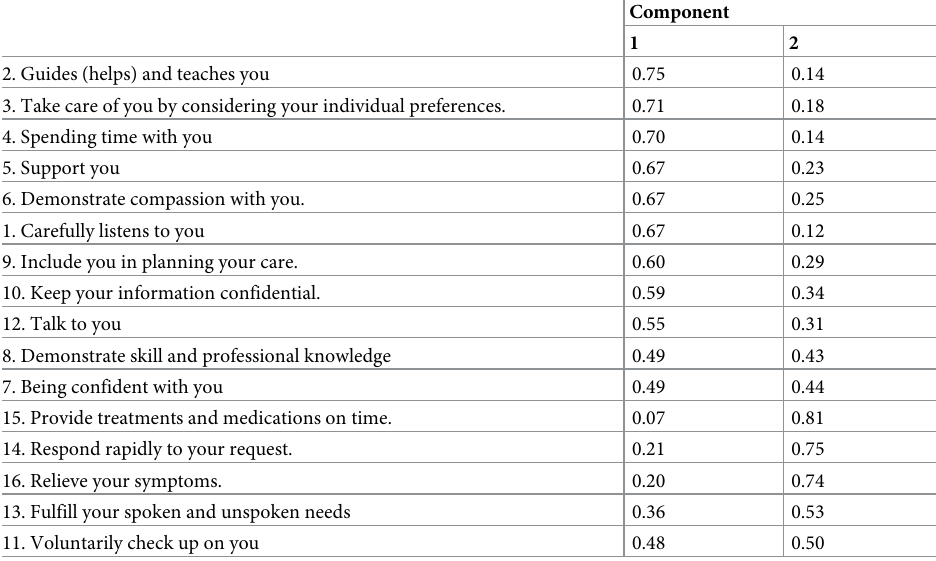
Table 4. CBI exploratory factor